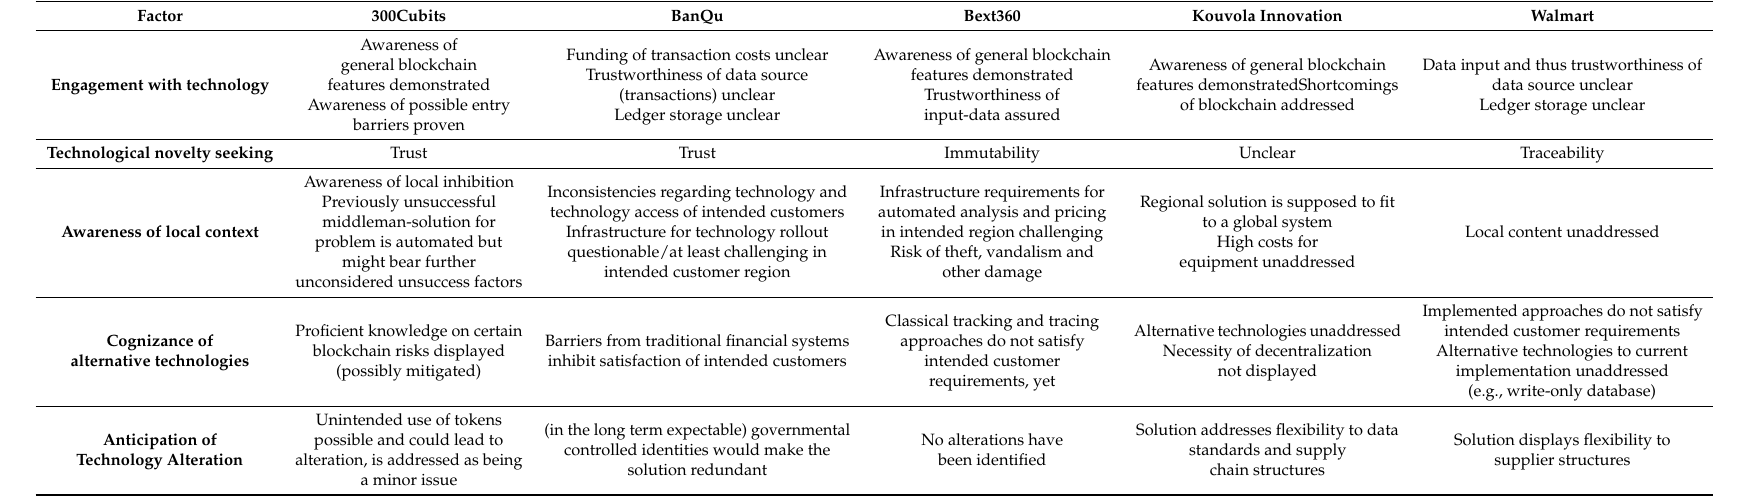
Table 2. Final case